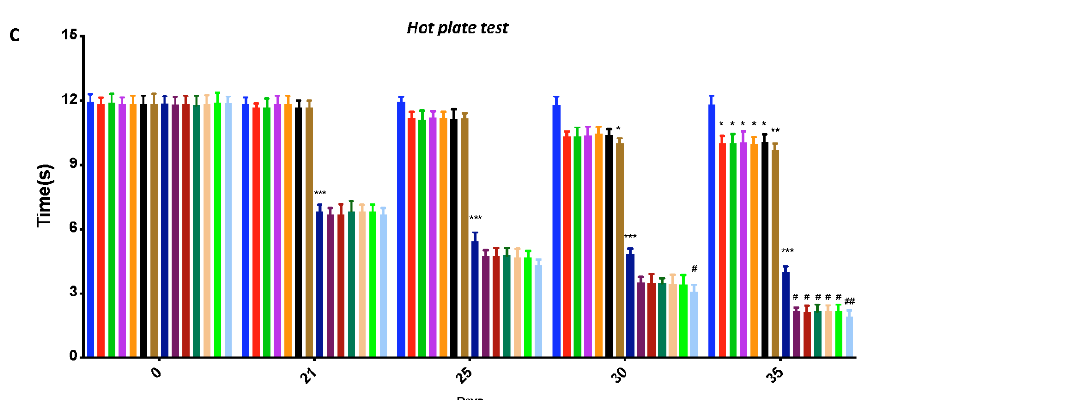
Figure 1. Behavioral analysis: rotarod test for locomotor ability ( A ); plantar test for thermal hyperalgesia ( B ); hot-plate test for pain sensitivity ( C ). * p < 0.05 vs. sham; ** p < 0.01 vs. sham; *** p < 0.001 vs. sham; # p < 0.05 vs. CIA; ## p < 0.01 vs. CIA; ### p < 0.001 vs. CIA.